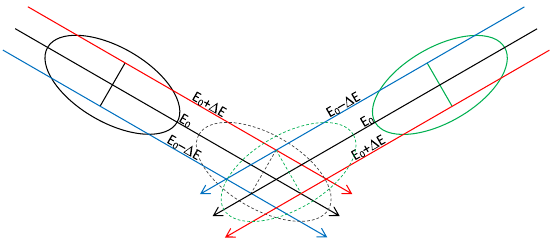
FIG. 3. Crossing angle collision with opposite dispersion.